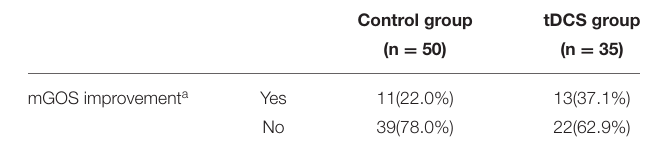
TABLE 2 | Demographic characteristics of the patients. TABLE 3 | mGOS